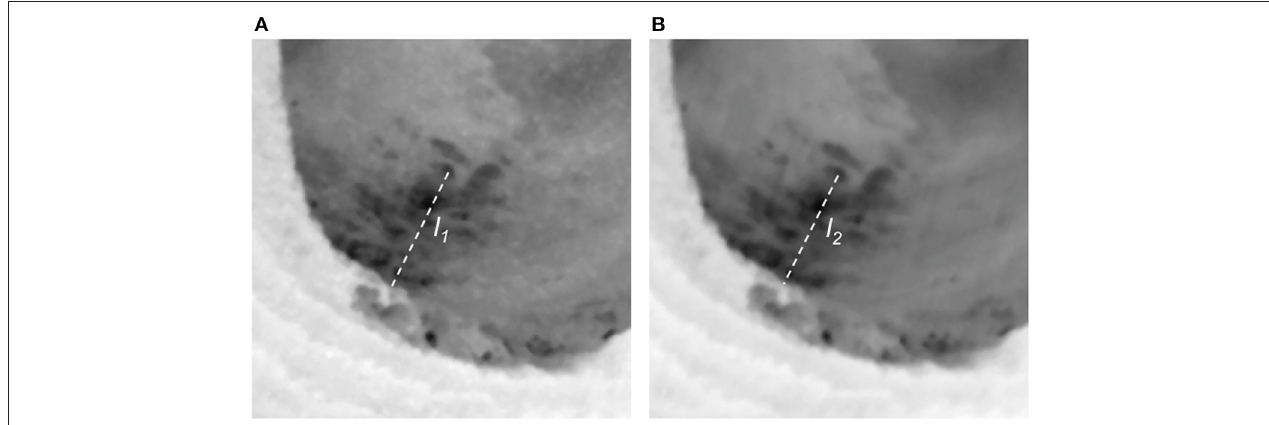
FIGURE 3 | Enlarged view (600m by 600m) of the southwest part of the eddy, from the 2101 UTC overpass. (A) Image made using forward scanlines; (B) Image made using rear scanlines. The time difference between views is 32.4s. Small-scale thermal structure can be seen to persist between views, and thus provides a good tracer of motion. Line ( l 1 ) in (A) , drawn between a randomly chosen cold patch and the eddy perimeter, is 201m in length; a similarly drawn line ( l 2 ) in (B) is shorter by about 9m, thus indicating outward radial motion.